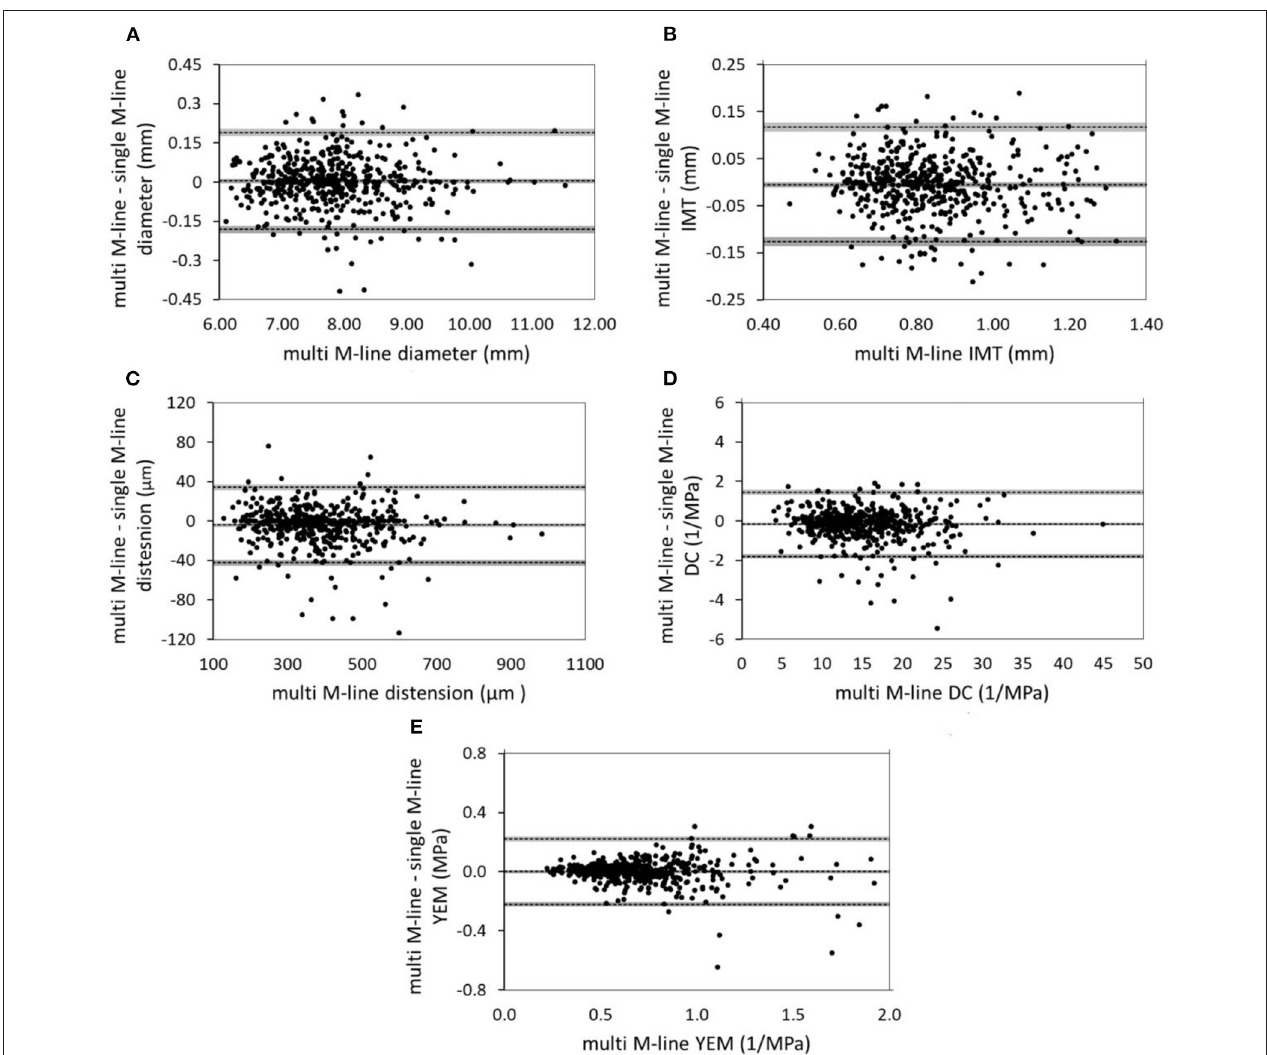
FIGURE 2 | Bland-Altman plots show good agreement between single and multiple-M-line approaches in estimating (A) diameter, (B) IMT, (C) distension, (D) DC, and (E) YEM. The gray areas indicate the 95% CIs of the bias and the limits of agreement. IMT, intima media thickness; DC, distensibility coefficient; YEM, young’s elastic